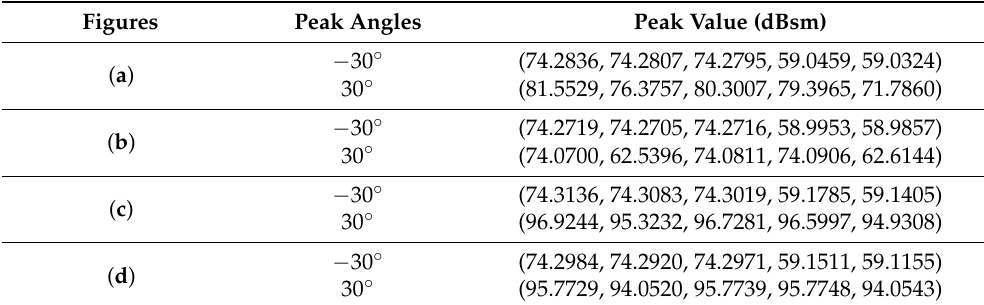
Table 3. Peak values of different roughness